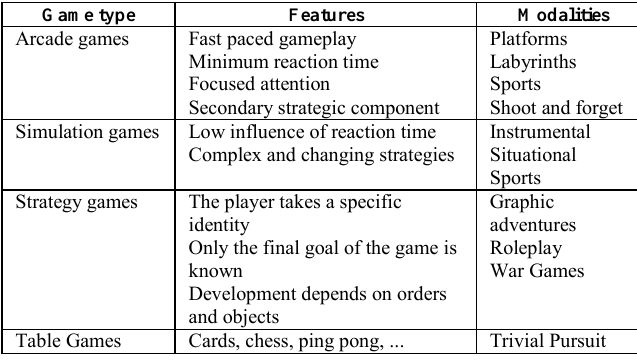
Table 1. Video game modalities